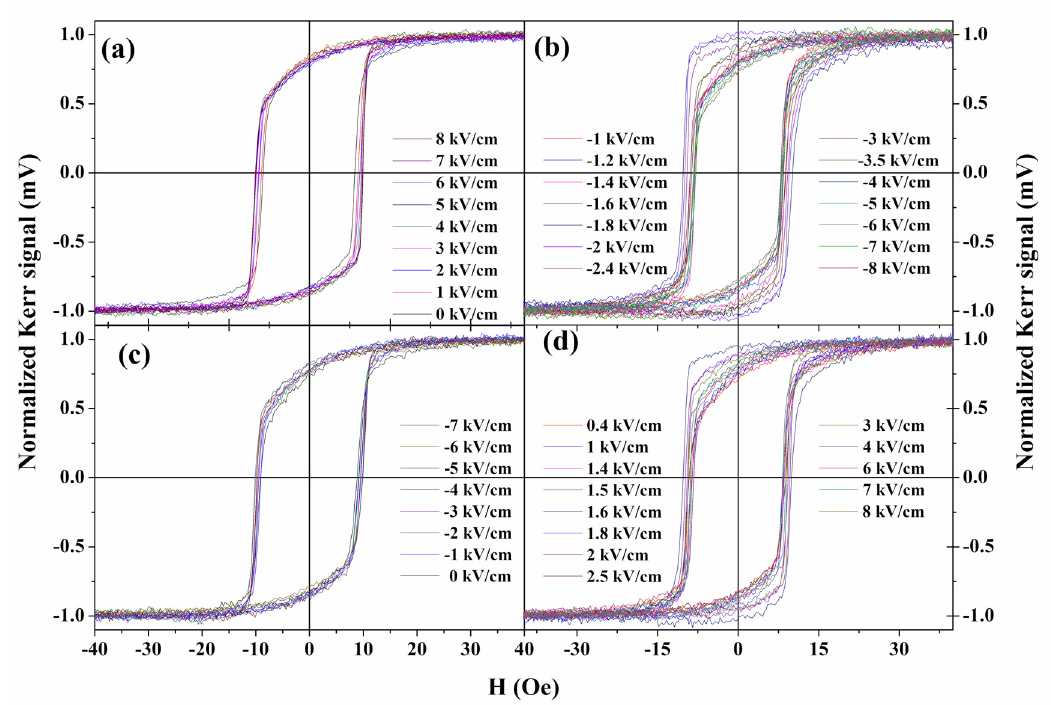
Figure 6. Longitudinal Kerr M–H loops as a function of bipolar electric fields (( a , c ) correspond to the descent branches of electric fields. ( b , d ) correspond to the ascent branches of electric fields) with H along the φ = 75° direction.